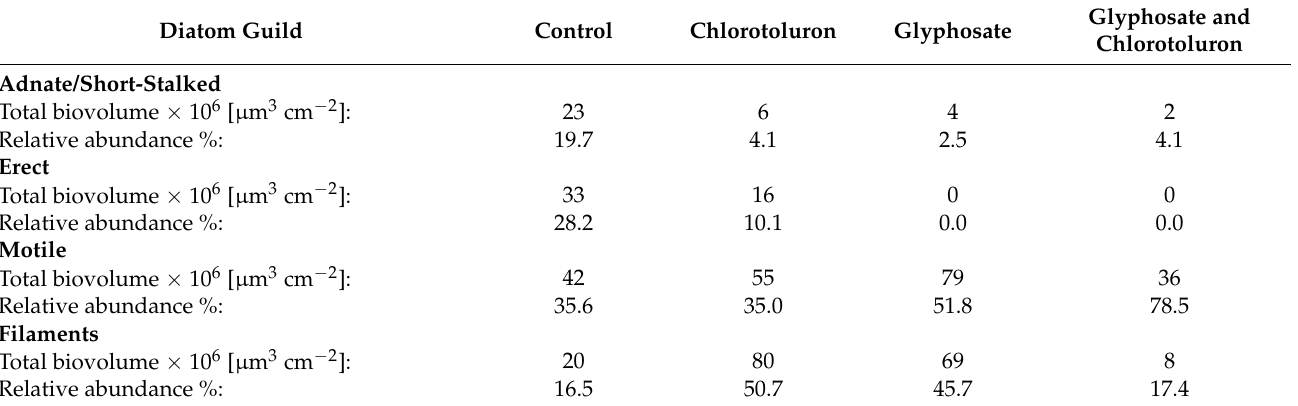
Table A1. Mean relative abundance (based on estimated biovolume) assigned to benthic diatom guilds in phytobenthos four days into a recovery phase following an acute treatment of herbicides where CON = control, CLT = chlorotoluron, GBH = glyphosate-based herbicide, and GBHC = a combined GBH and CLT treatment. Diatoms were assigned to guilds according to their growth form within the biofilms. Relative abundance % = Total Estimated Relative Percentage Biovolume (%) of Benthic Diatoms (number of replicates = 3).